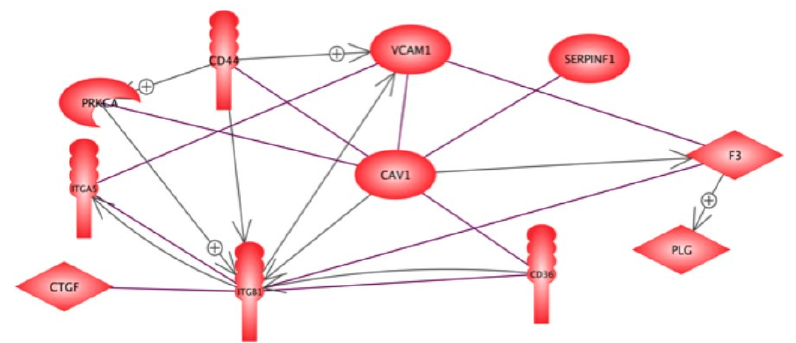
Figure 4. Proteins binding to and interacting with caveolin-1.